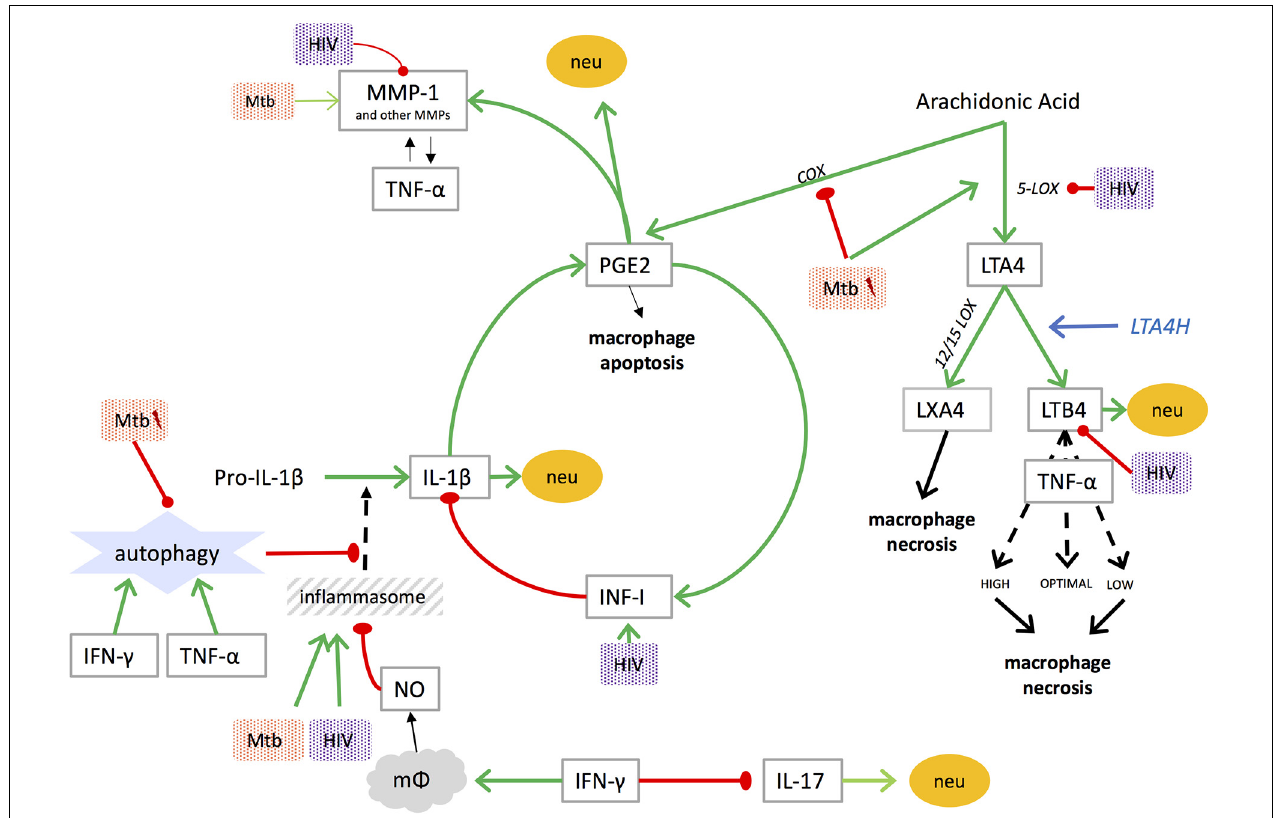
FIGURE 1 | Mediators of lung damage in TB and interplay with [lightning flash cartoon], virulent Mtb; COX, cyclooxygenase; IFN-I, type I interferon; IFN- γ , interferon gamma; IL, interleukin; LOX, lipoxygenase; LT, leukotriene; LTA4H, leukotriene A4 hydrolase; LX, lipoxin; m ϕ , macrophage; MMP, matrix metalloproteinase; Mtb, mycobacterium tuberculosis; neu, neutrophil recruitment; NO, nitric oxide; PGE2, prostaglandin E2; TNF, tumor necrosis factor. NO inhibits assembly of the NLRP3 inflammasome (Mishra et al.,